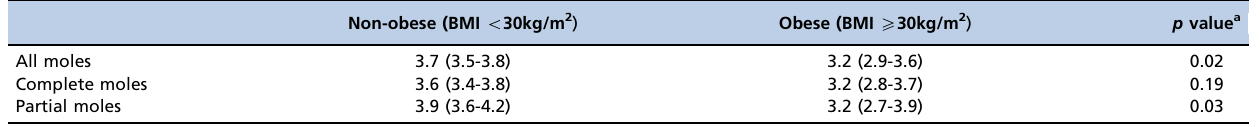
Table S6 - Comparison of hCG half-lives (in days) by body mass index (BMI) among women with hydatidiform molar pregnancies, adjusted for age and race/ethnicity with 95% Confidence Intervals.